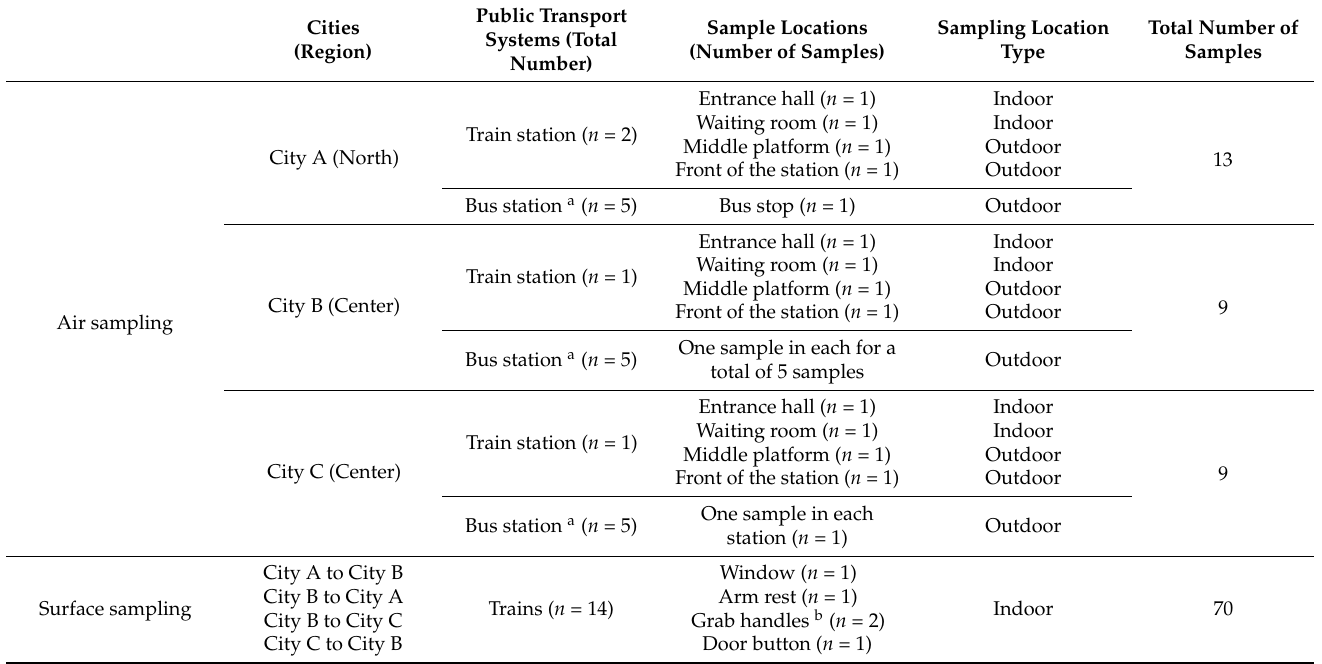
Table 1. Details of air and surface sampling sites in the public transport systems of three major cities in Portugal,